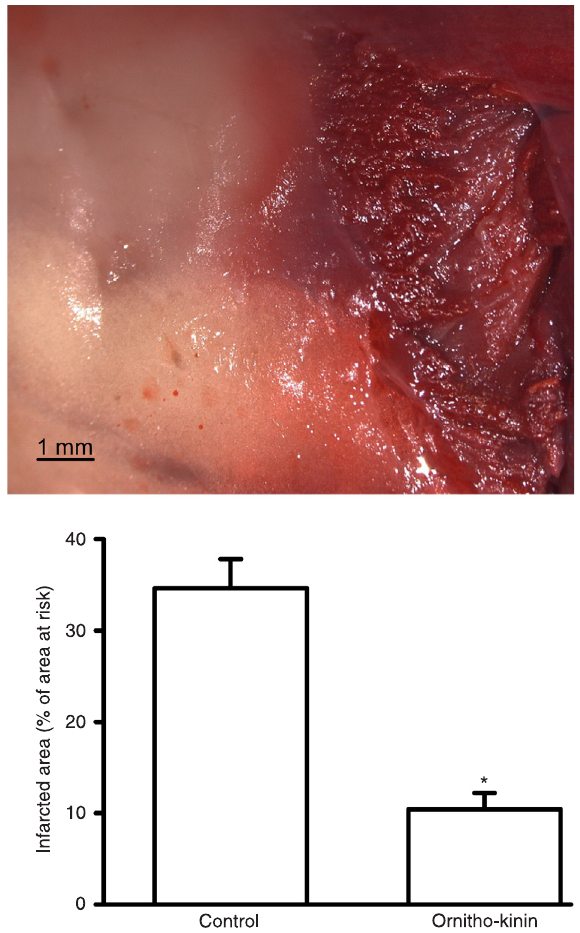
Figure 4. Effect of pretreatment with ornitho-kinin (500 µg/kg perfused for 5 min) on infarct size induced by coronary artery oc- clusion in anesthetized chickens. Top , Section of a triphenyltetra- zolium chloride-stained wall of the left ventricle with healthy (red) and infarcted (pale) tissue. Data are reported as means ± SEM in the bar graph for 8 animals each dose. * P < 0.05 vs saline control (ANOVA and post hoc t -tests with Bonferroni’s